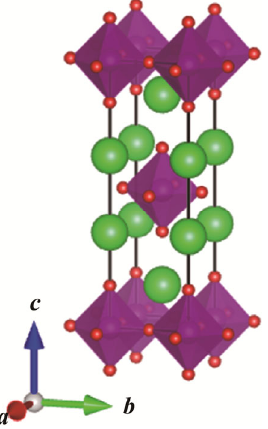
Fig. 1 Ideal tetragonal unit cell of stoichiometric A (cid:2870) BO (cid:2872) layered perovskite crystalized in (cid:1835)4/(cid:1865)(cid:1865)(cid:1865) space group.